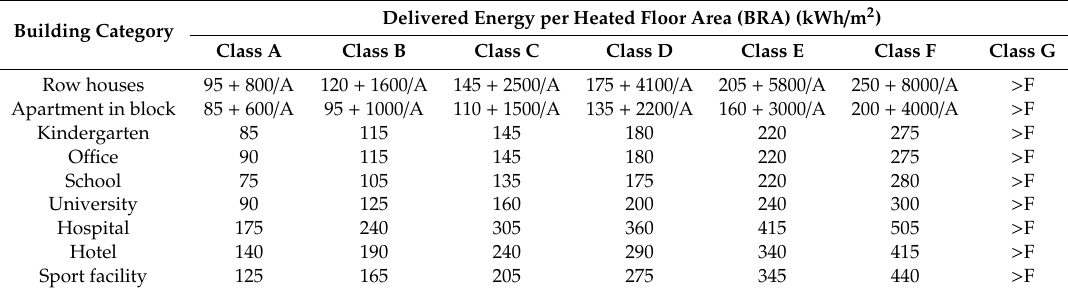
Table 11. Delivered energy per heated floor area for di ff erent building categories.